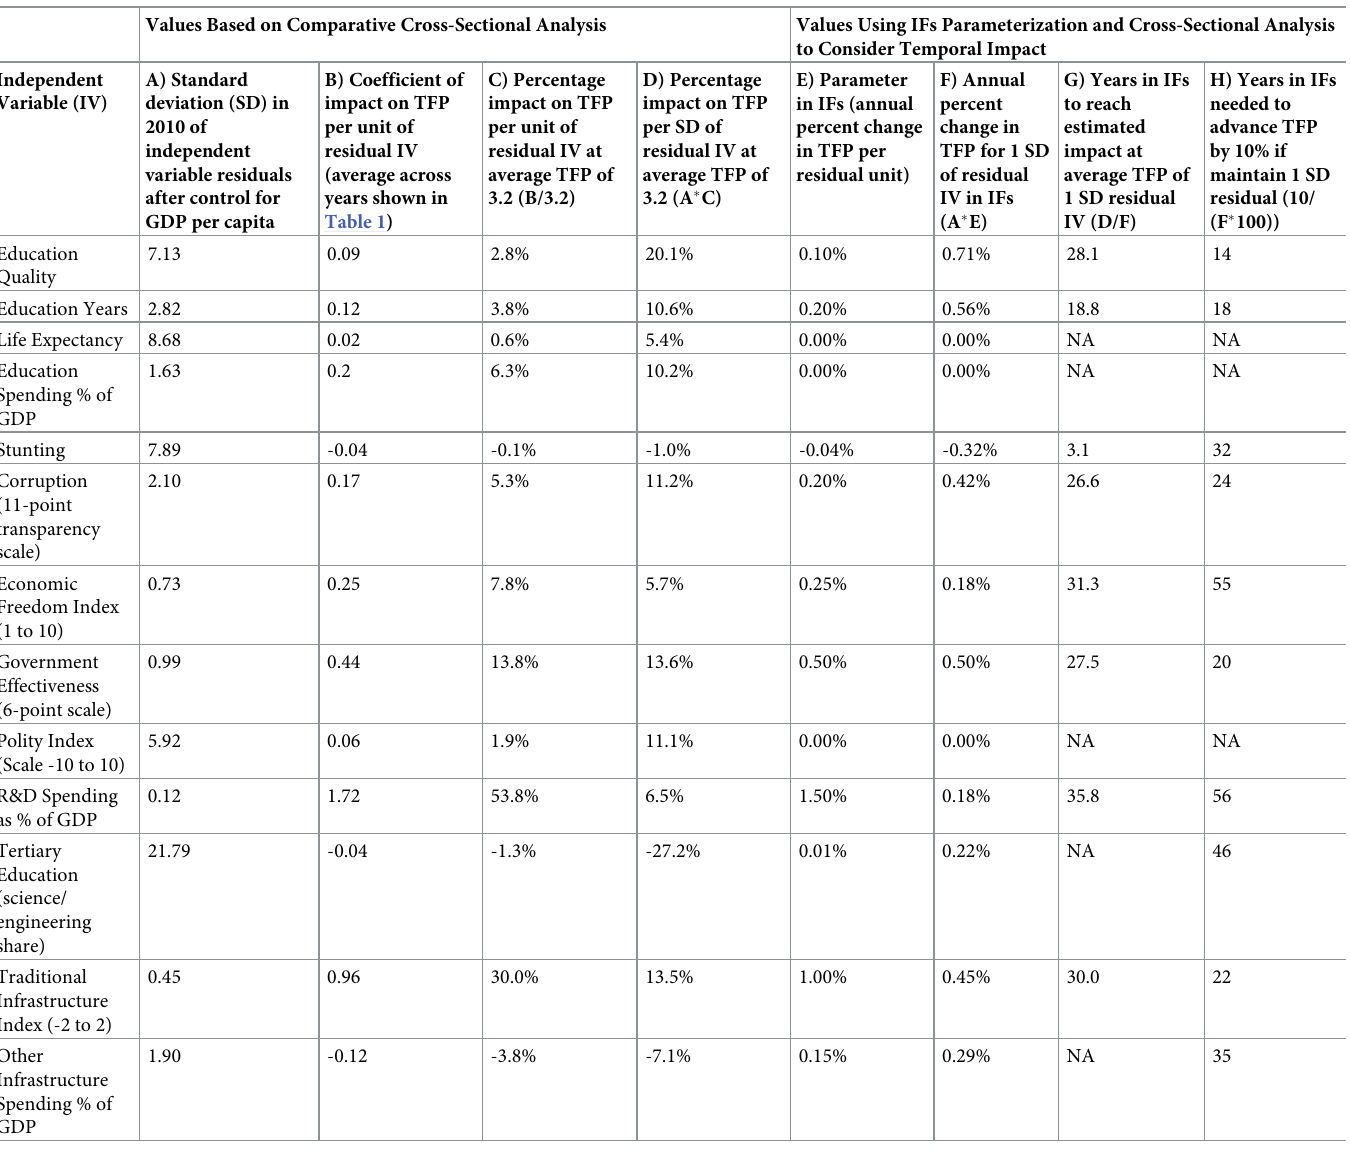
Table 3. Parameterization and temporal dynamics in the IFs productivity representation. Values Based on Comparative Cross-Sectional Analysis Values Using IFs Parameterization and Cross-Sectional Analysis to Consider Temporal